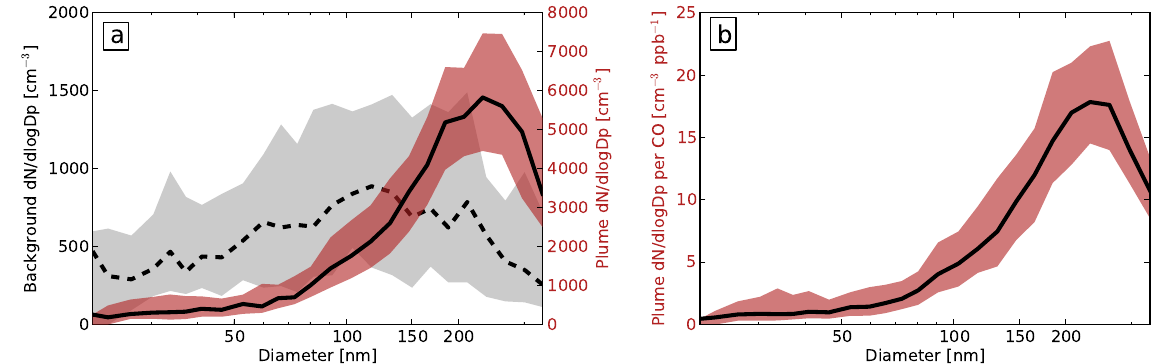
Figure 5. Composite median number–size distributions for Flights b622 and b623 (cm − 3 at STP). The in-plume (red) and background (grey) air distributions are shown as absolute concentrations (a) . The in-plume distributions are also normalized by CO mixing ratio (b) . The black lines are the median with the 25th and 75th percentiles overlain. The plume distributions have D pm = 230nm.